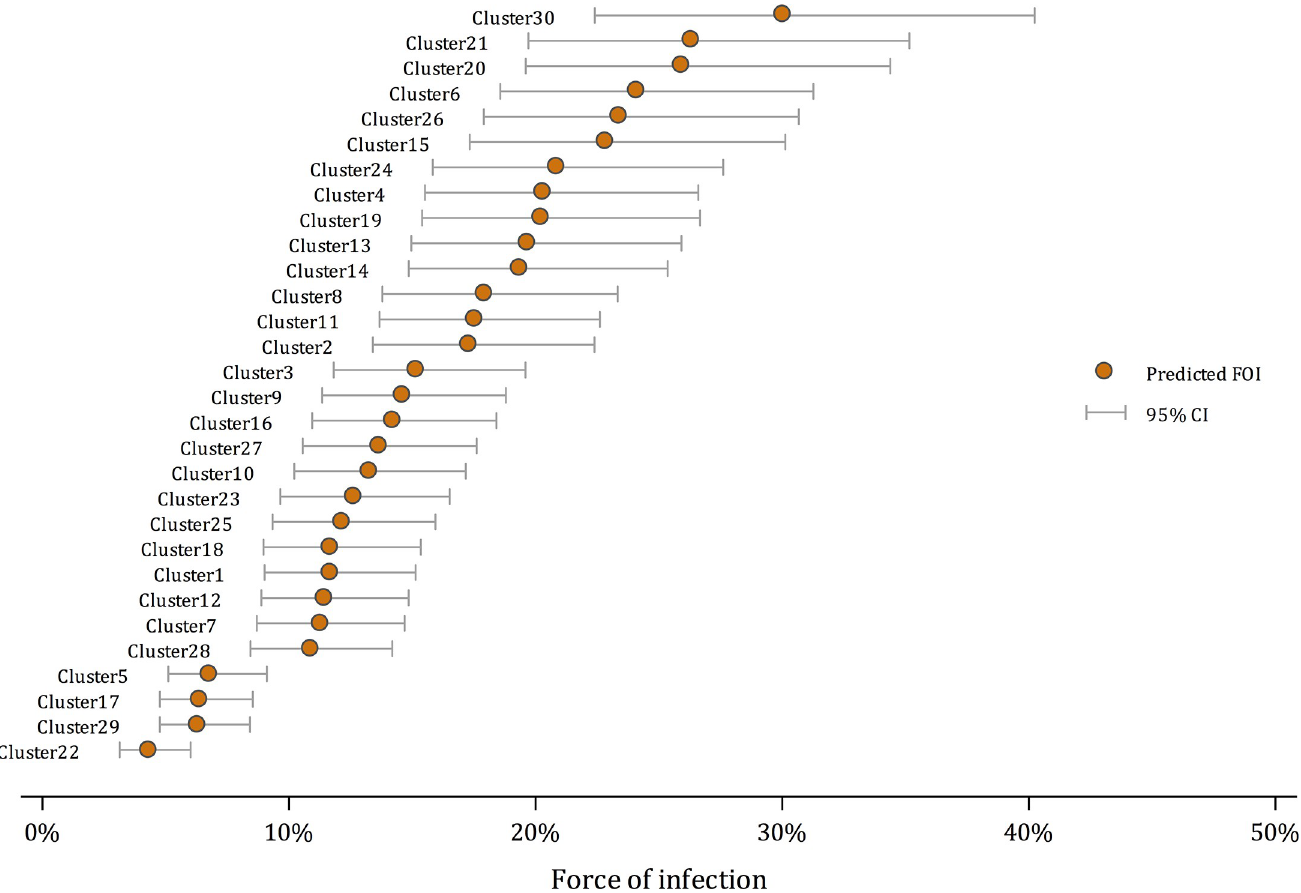
Fig 2. Estimated cluster-specific annual forces of infection with associated 95% confidence intervals among children aged 1 to 18 years in Indonesia,